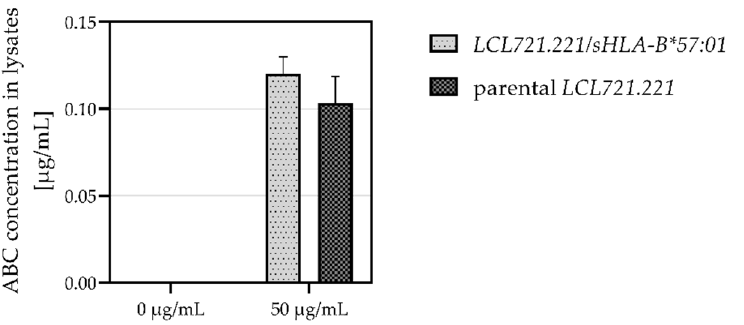
Figure 2. ABC concentration in parental LCL721.221 and LCL721.221/sHLA-B*57:01 cell lysates. Cells were incubated without or with 50 µg/mL ABC for 48 h and ABC concentrations were measured in cell lysates of three technically independent replicates ( n = 3) by UPLC-MS/MS.